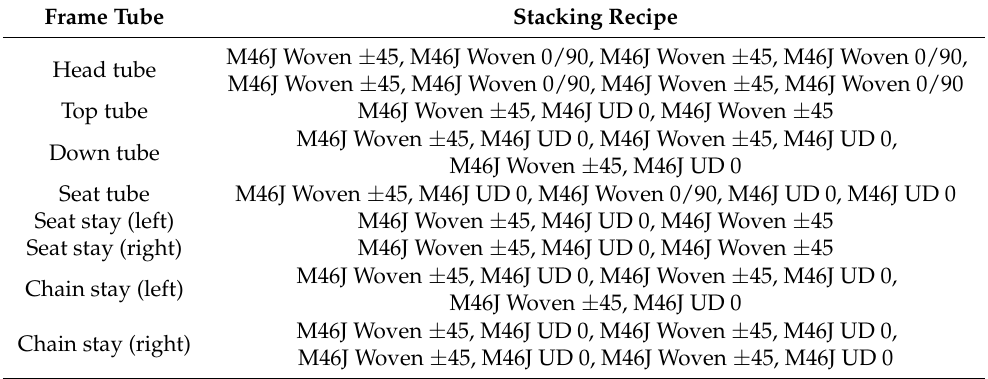
Table 10. Stacking scenario 7.